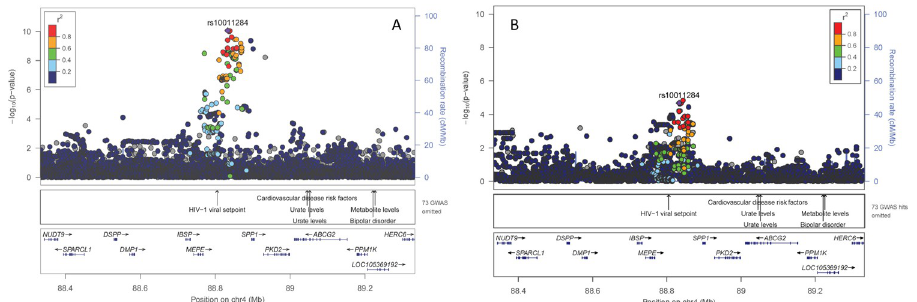
Fig 1. Regional association plot for the region around rs10011284 on chromosome 4: (A) GCKD study (discovery) and (B) YFS cohort (replication). Plots are produced in LocusZoom and show the most strongly associated SNP (purple diamond), SNP colors reflect LD correlation (r 2 ) using 1000G EUR population as reference. The -log 10 p- values (left y-axis) of SNPs are shown according to their chromosomal positions (x-axis, GRCh37); the genetic recombination rates are shown on the right y-axis. The -log 10 p-values are shown for both genotyped and imputed SNPs distributed in a 0.8-megabase genomic region.